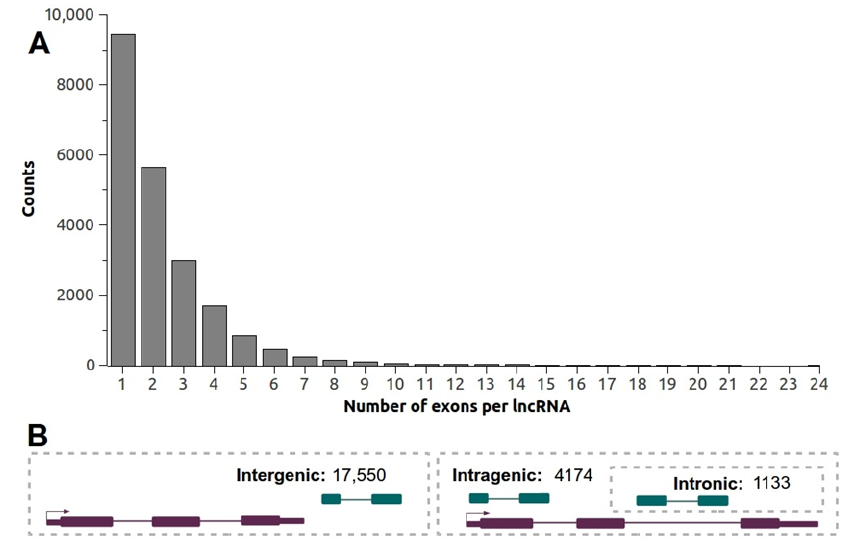
Figure 4. ( A ) Distribution of the number of exons per lncRNA obtained by the mapping Lluteño lncRNAs against B73 variant; ( B ) General overview of the genomic organization and structure of Lluteño lncRNAs according to B73 genome sequence. Purple blocks and lines represent protein coding genes, while dark green blocks and lines represents lncRNAs.